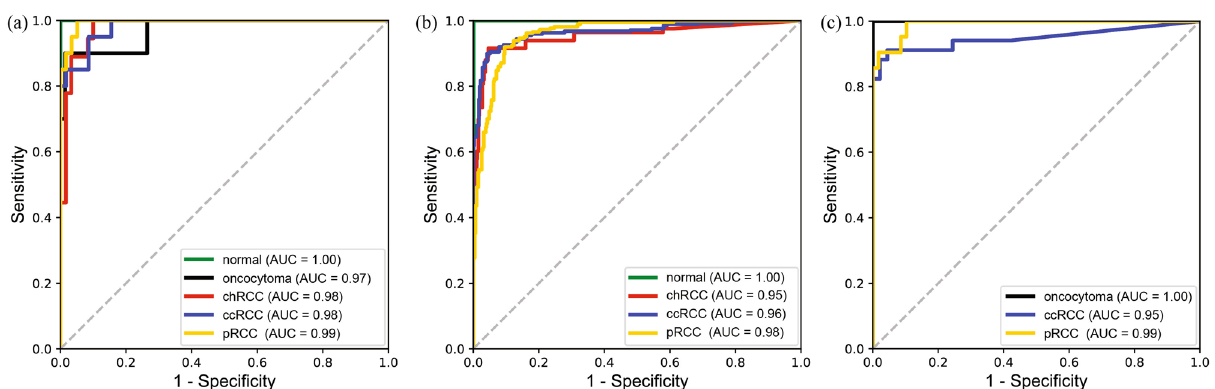
Figure 2. Receiver operating characteristic curves for ( a ) surgical resection whole-slide images from DHMC, ( b ) surgical resection whole-slide images from TCGA, and ( c ) biopsy whole-slide images from